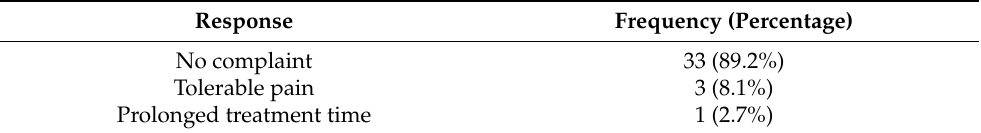
Table 3. Post-surgical